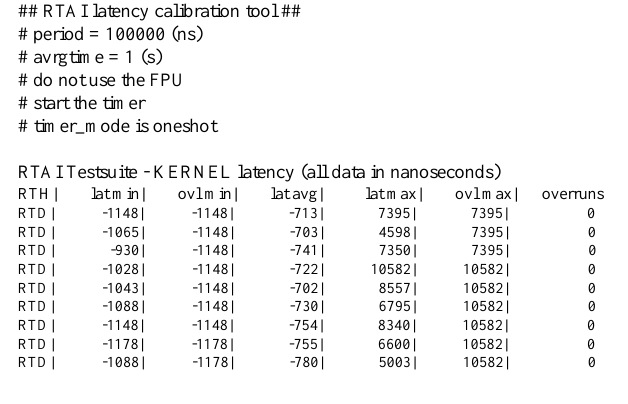
Figure 1. Real Time Application Interface (RTAI) Timer latency test result.